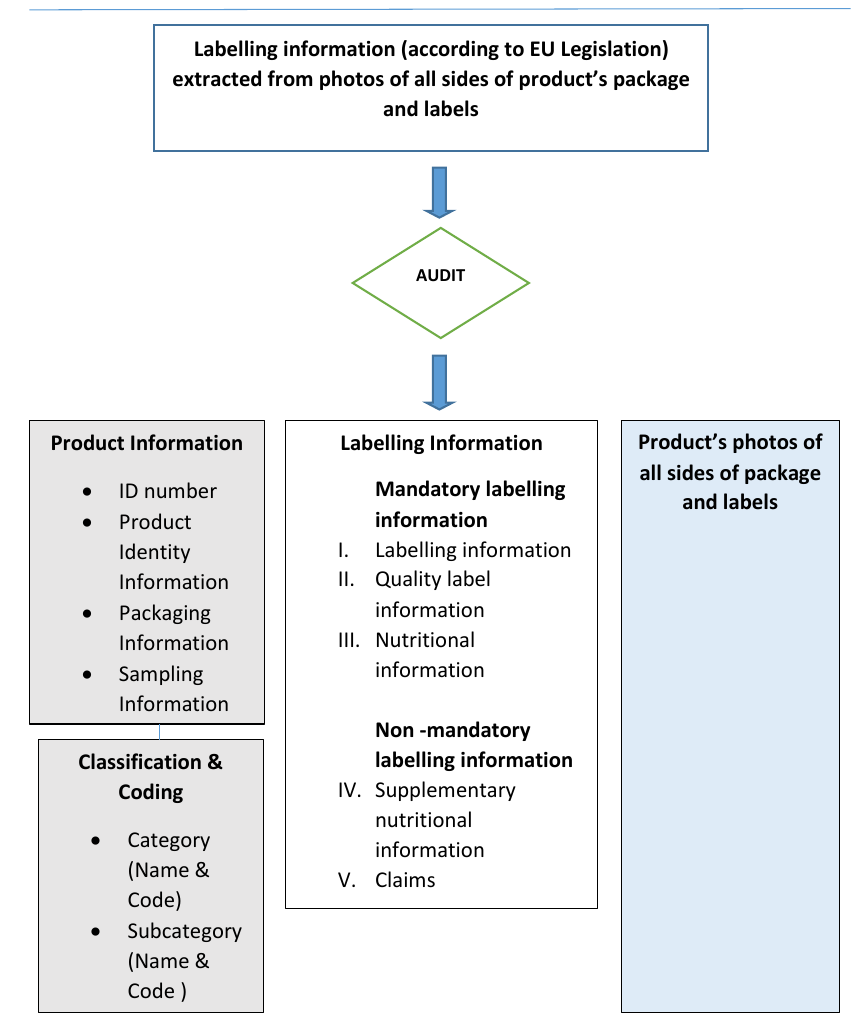
Figure 3. Flow-diagram presenting methodology for label data collection and structure.